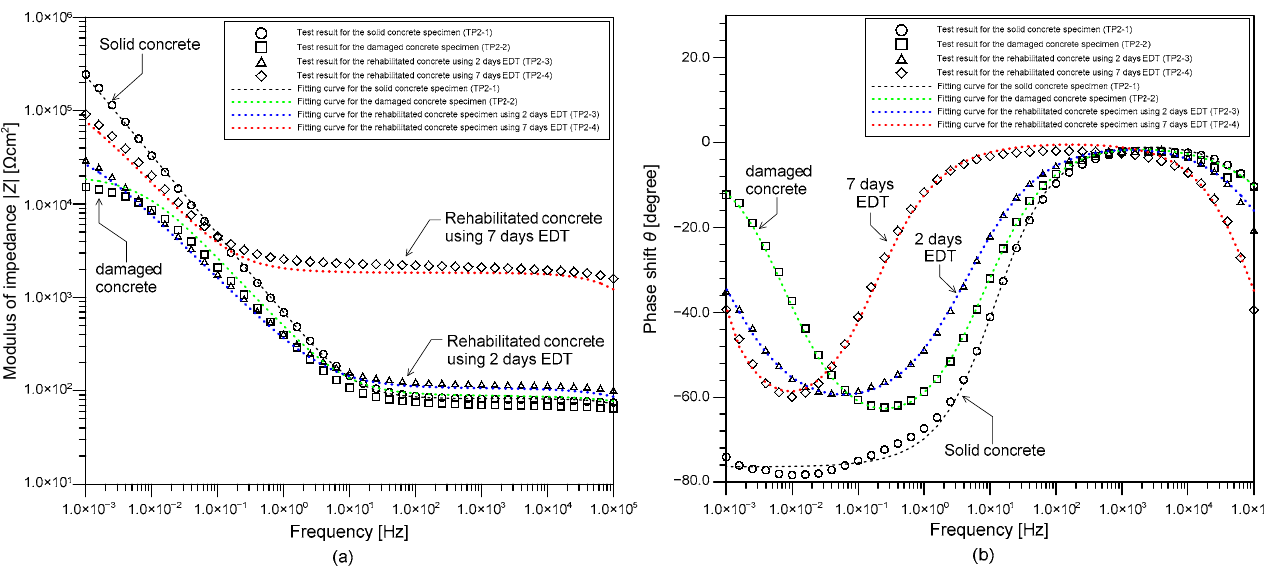
Figure 9. Experimental bode diagram and curve fitting for reinforcing steel in 0.5M NaCl solution: ( a ) modulus of impedance and ( b ) phase shift of impedance with ( ○ ) passive rebar in the concrete sample TP2-1, ( □ ) corroded rebar in the concrete sample TP2-2, ( ◊ ) electro-deposited rebar with − 2 μ Acm − 2 for 2 days in the concrete sample TP2-3, ( Δ ) electro-deposited rebar with − 2 μ Acm − 2 for 7 days in the concrete sample TP2-4, respectively. Table 3. Fitting parameters used for curve-fitting in Figure 9a,b. Fitting Parameters Specimen No.